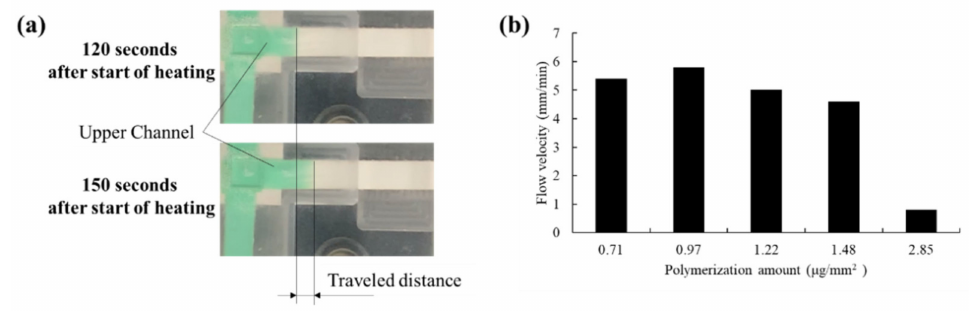
Figure 8. Comparison of flow velocities in the upper channel for membranes with various amounts of polymerization. ( a ) Method for measuring flow velocity. ( b ) Relationship between flow velocity and amount of polymerization. Flow velocity was calculated by measuring the difference of the distance of the wetting front at 120 and 150 s after heating was